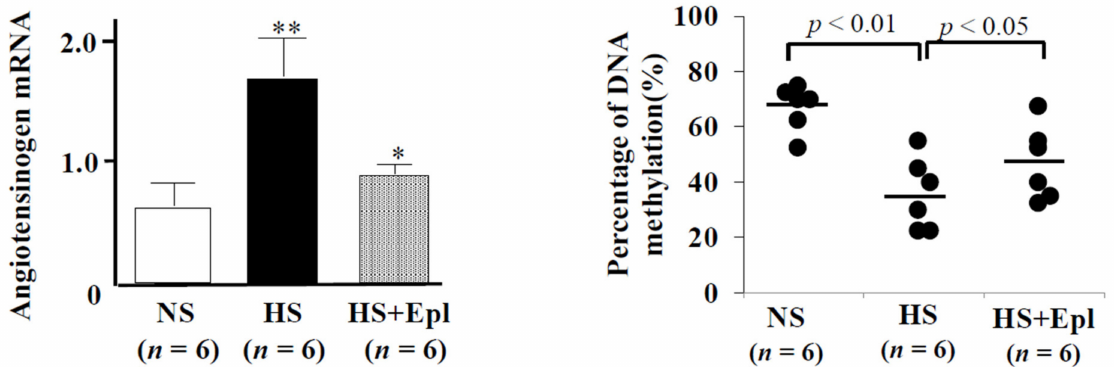
Figure 3. Effects of a high-salt diet on ATG mRNA expression and methylation of ATG in the heart of SSH rats. A low-salt diet significantly increased the ATG mRNA levels and decreased the methylation ratio of ATG . Treatment with eplerenone decreased the ATG mRNA levels and increased the methylation ratio of ATG . NS, normal-salt diet; HS, high-salt diet; HS + Epl. High-salt diet with treatment with eplerenone. ** p < 0.01 vs. NS; * p < 0.05 vs.